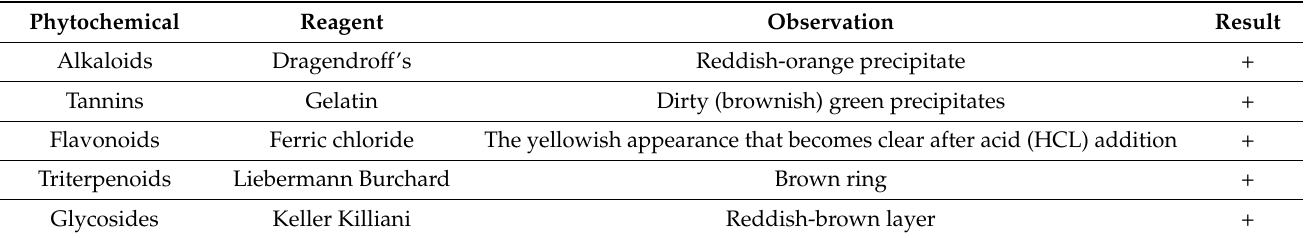
Table 1. Phytochemical screening (qualitative) of A. articulata crude extract.